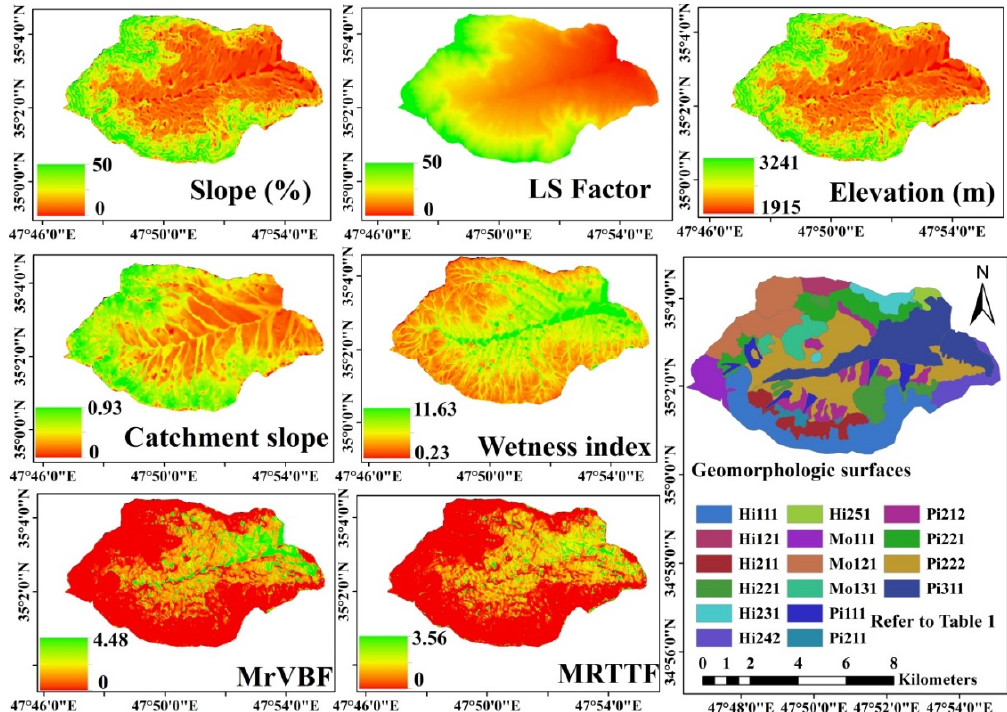
Figure 3. Eight most important auxiliary variables derived from Landsat spectral data and digital elevation models in the study area: MrVBF: multi-resolution valley bottom flatness index; MrRTF: multi-resolution ridge top flatness. (Geomorphic surfaces codes refer to Table A1 in Appendix A). Terrain attributes including multi-resolution ridge top flatness (MrRTF), catchment network base level (CNBL), elevation (EL), catchment slope (CS), slope (SL), aspect (AS), length-slope factor (LS factor), plan curvature (PC), long curvature (LC), cross curvature (CC), valley depth (VD), topographic wetness index (TWI), and the multi-resolution index of valley bottom flatness (MrVBF)